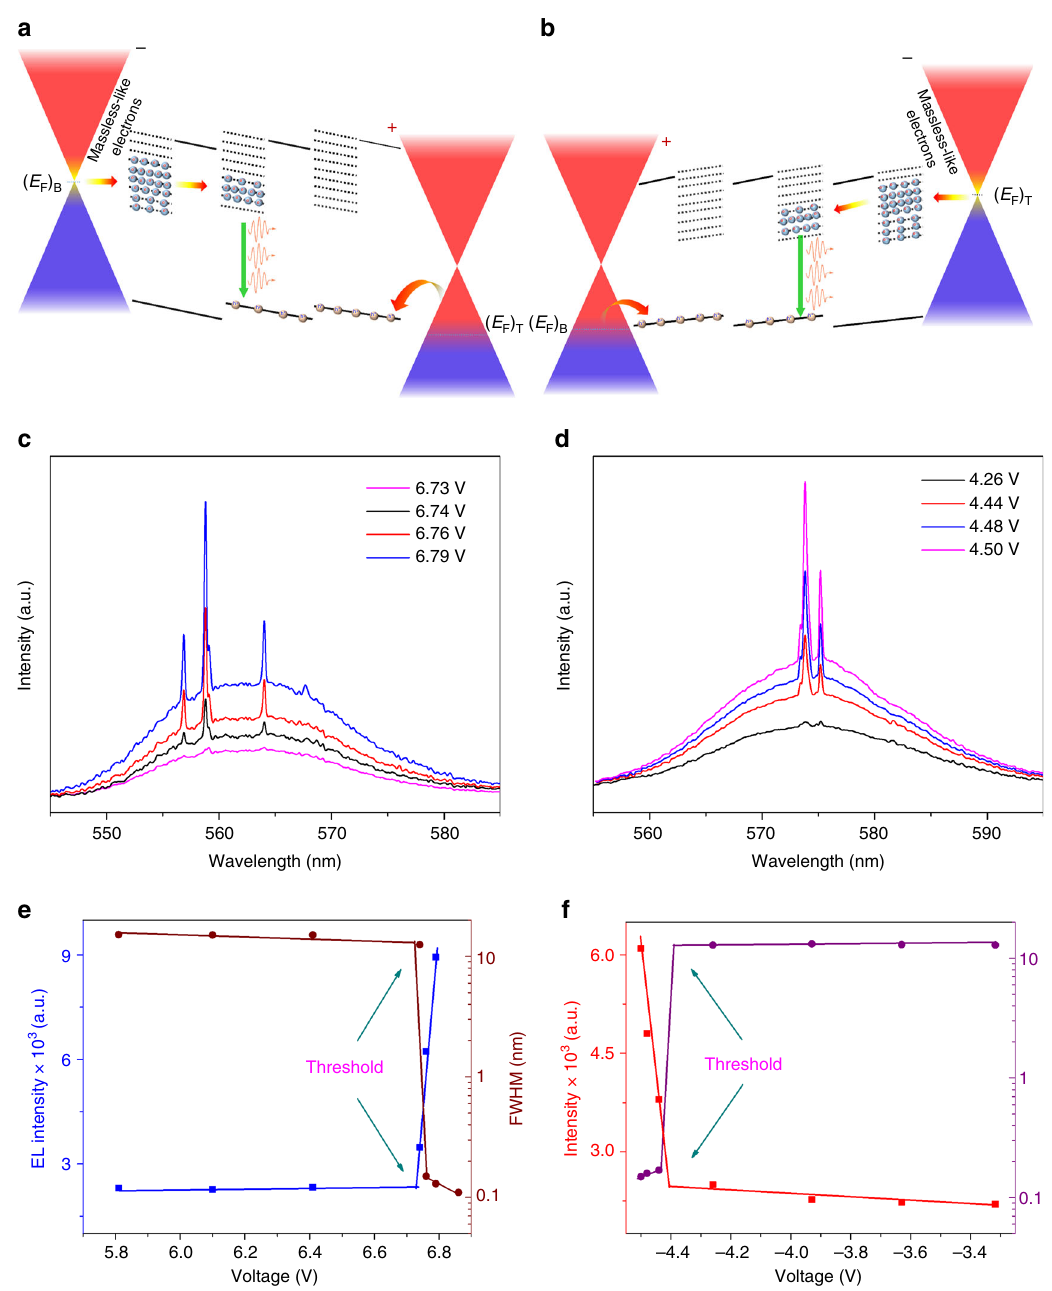
Fig. 3 Dirac point assisted laser action. a , b Schematic illustration of avalanche tunneling of massless-like electrons close to the Dirac point for opposite bias, respectively, which results in population inversion in GQDs. c , d EL spectra of the device for positive and negative bias, respectively. The full range EL spectra at a bias voltage of 6.76 and 4.48V, above lasing threshold are shown in the respective insets . e , f Dependence of integrated emission intensity and linewidth for the peaks centered at 568.8 and 573.5 nm on pumping voltage for positive and negative bias,